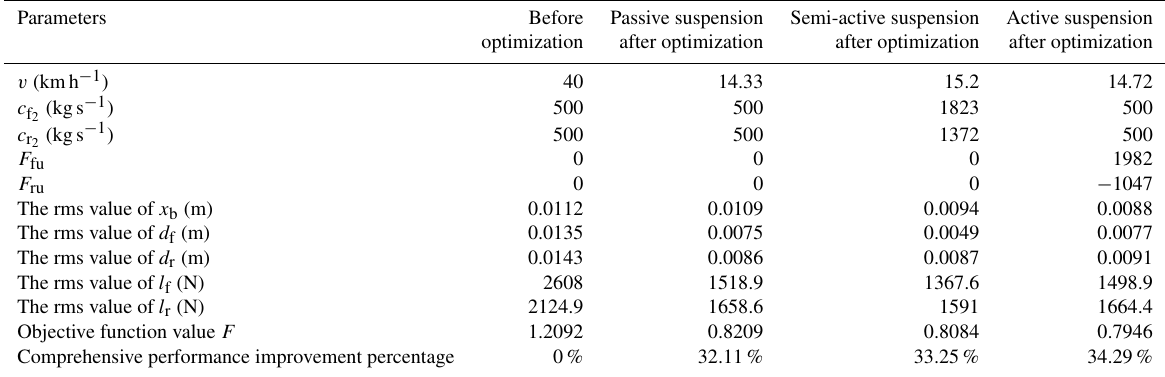
Table 3. Comparison of optimal results of three types of suspension. Parameters